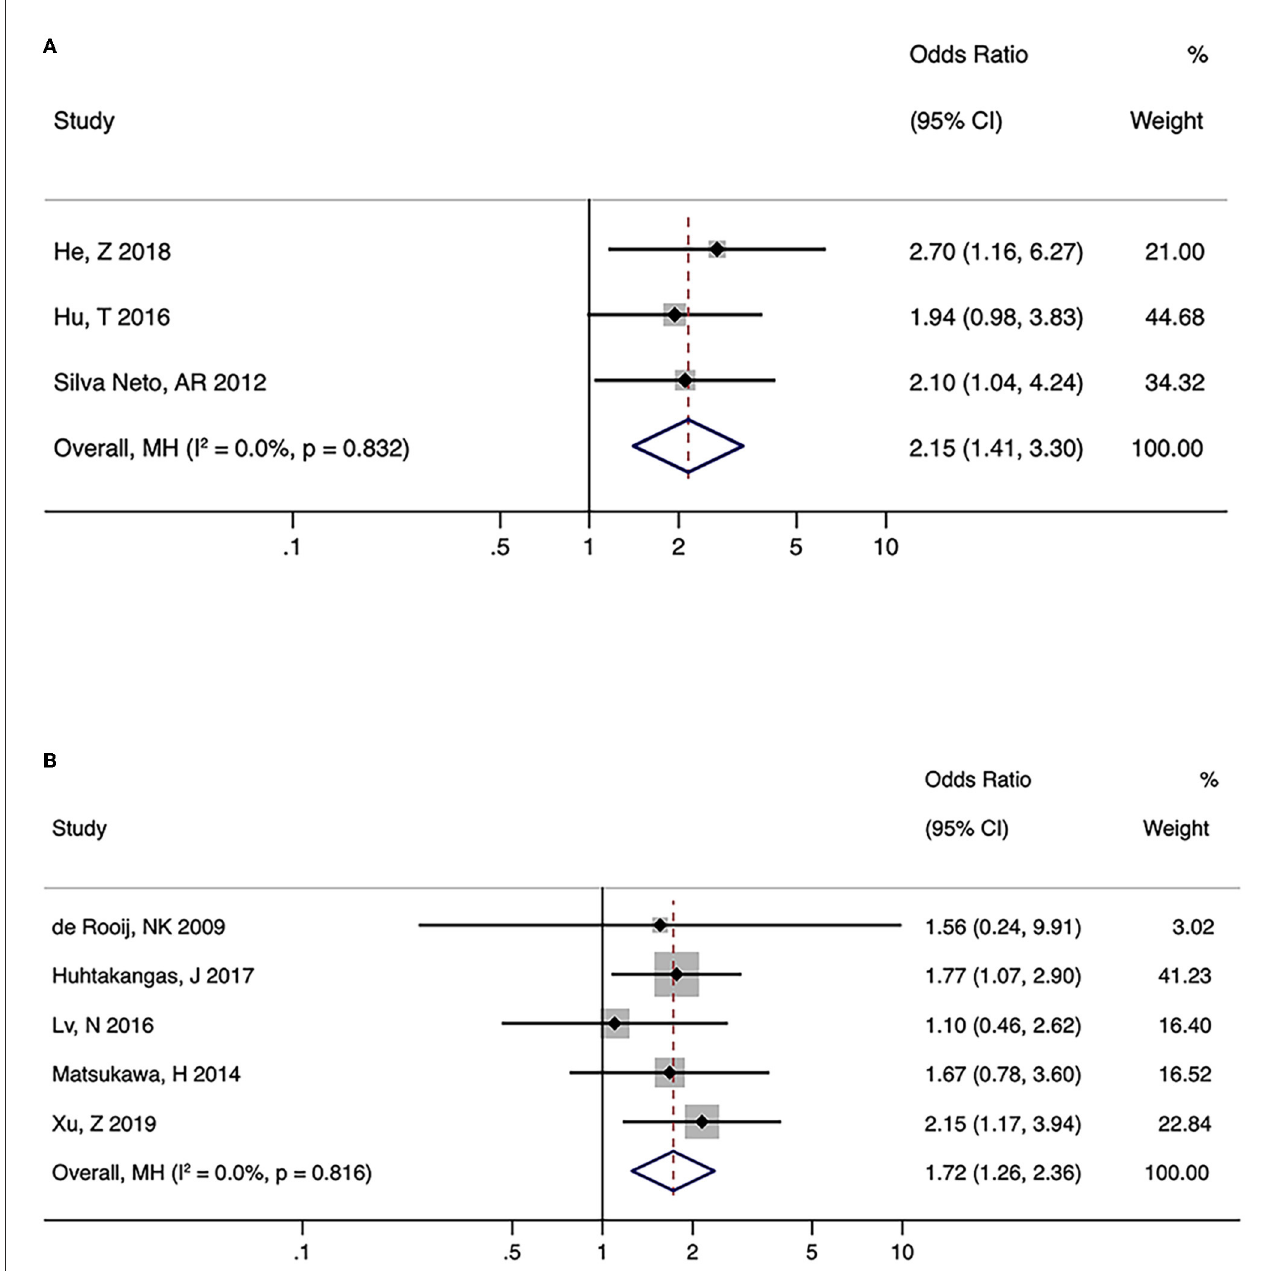
FIGURE3 Summary odds ratios of fetal-type posterior cerebral artery (FTP) and posterior communicating artery (PcomA) aneurysms. (A) PcomA aneurysms vs. controls (B) ruptured vs. unruptured PcomA aneurysms.